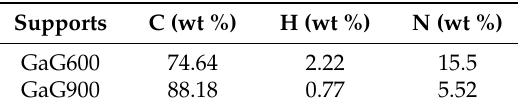
Table 2. Elemental analyses (C, H, N).